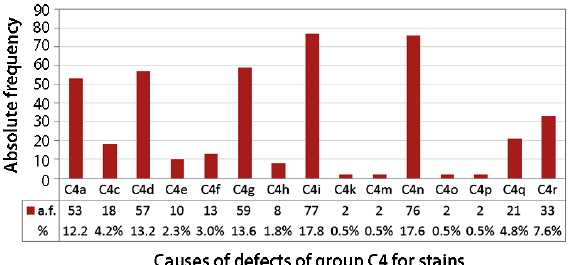
Fig. 30. Absolute frequency and percentage of specific causes belonging to group C4 for stains